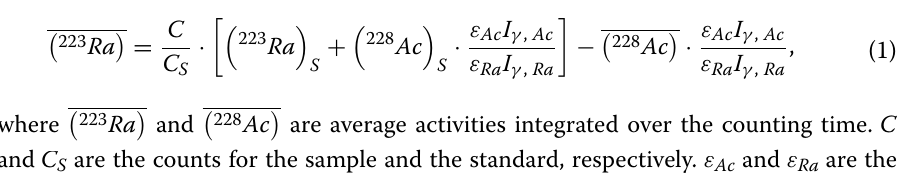
Data of gamma ray energies (Eγ) and intensities (Iγ) are from Condomines et al. (2010)